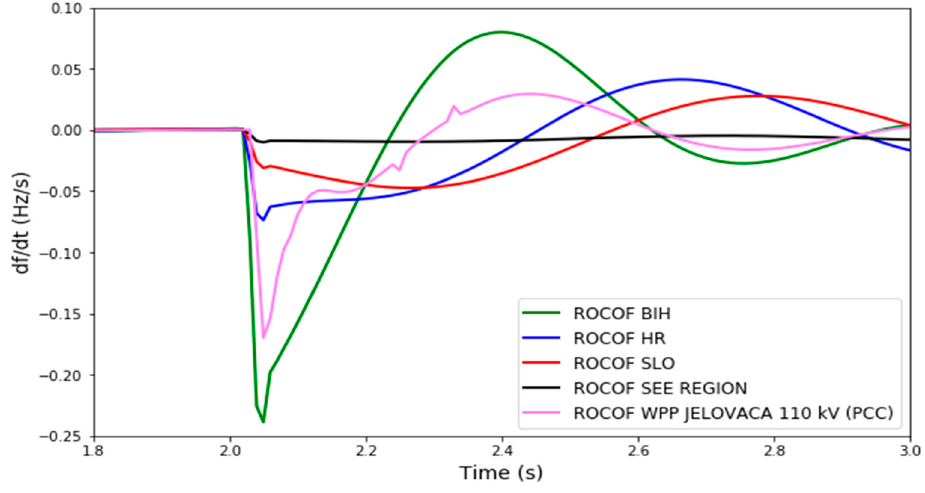
Figure 9. ROCOF of EPS.